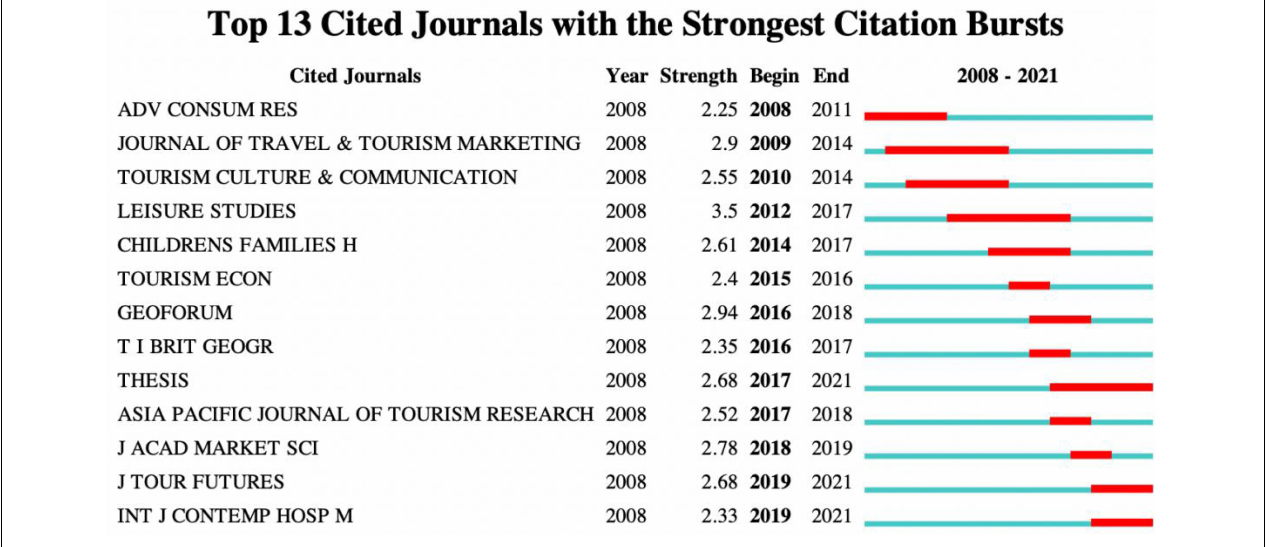
FIGURE 2 | Citation bursts of the top 13 journals. TABLE 2 | CiteSpace metrics by co-operation institutions network. Network Node type by year Modularity Nodes Links Density #Clusters Mean